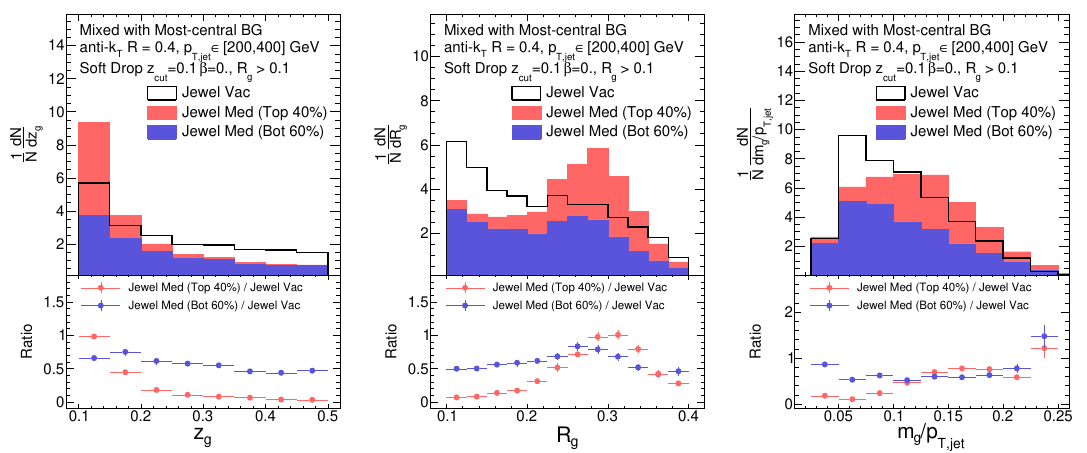
Figure 15 . Distribution of the substructure variables of the groomed jets. Samples of the positive class ( Jewel medium) are plotted with stacked